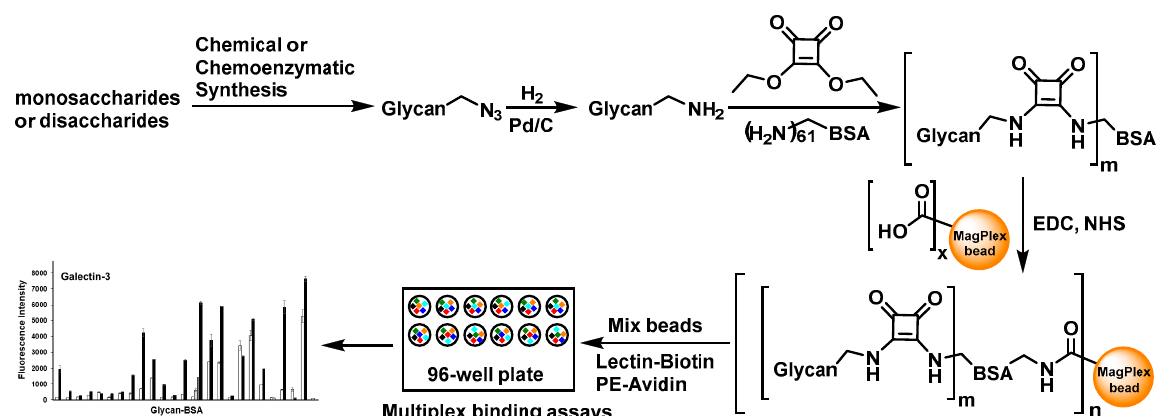
Figure 1. Design and workflow of glycan-BSA neoglycoprotein-immobilized MagPlex bead suspension multiplex array. Abbreviations: EDC and NHS: 1-ethyl-3-(3-dimethylaminopropyl) carbodiimide and N -hydroxylsuccinimide, reagents that activate carboxyl groups for conjugation with amines; PE: phycoerythrin, a red protein-pigment complex for fluorescence